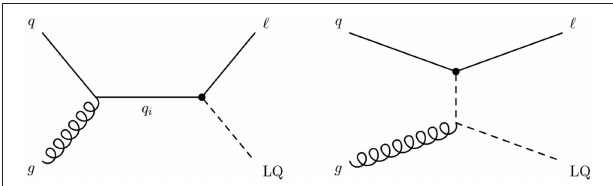
FIGURE 13 | Representative diagrams for single leptoquark production at pp colliders. Dots denote the LQ- q - ℓ coupling.